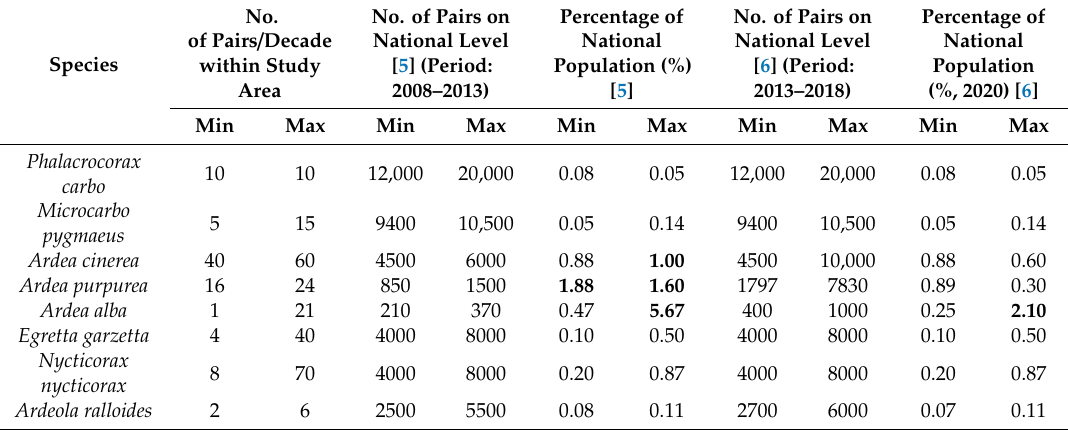
Table 3. Population size of analyzed species within study area and their comparison with the national population [5,6].